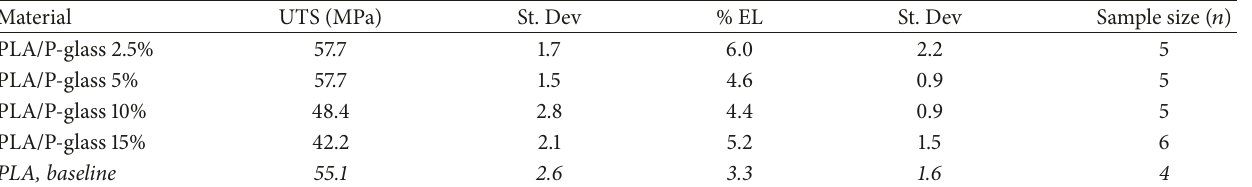
Table 5: Mechanical testing results for PLA loaded with P-glass at various weight percentages.